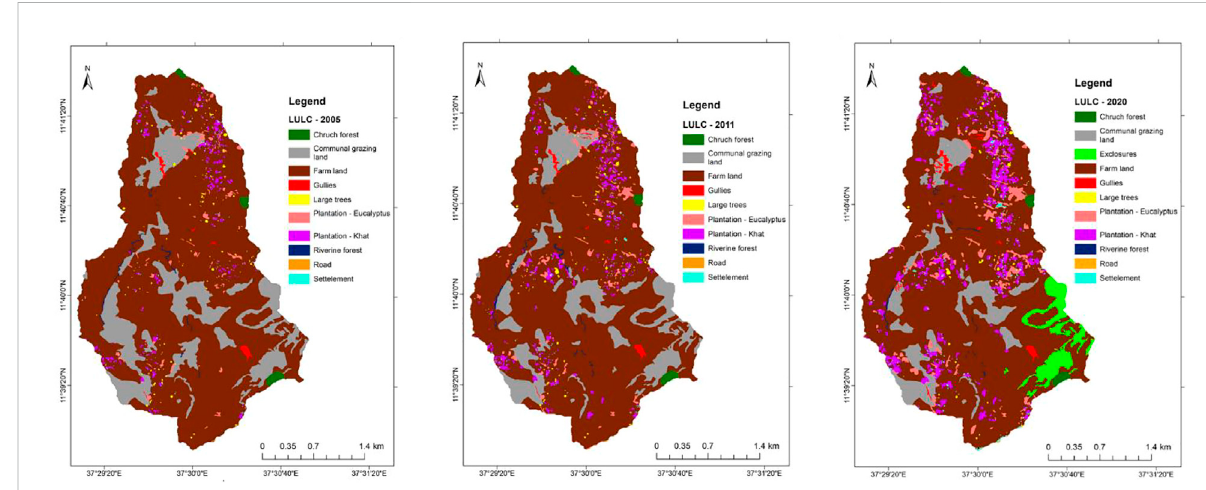
FIGURE 5 Land use and land cover changes between 2005 and 2020 in the Aba-Gerima watershed.